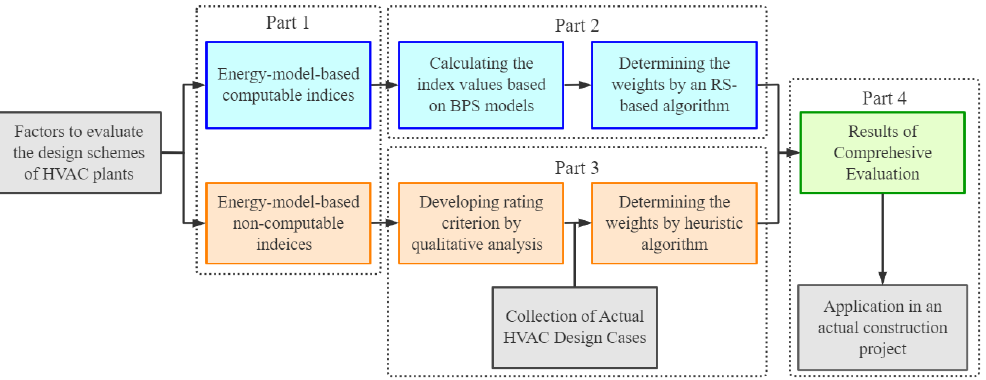
Figure 2. Description of the methodology of the process.